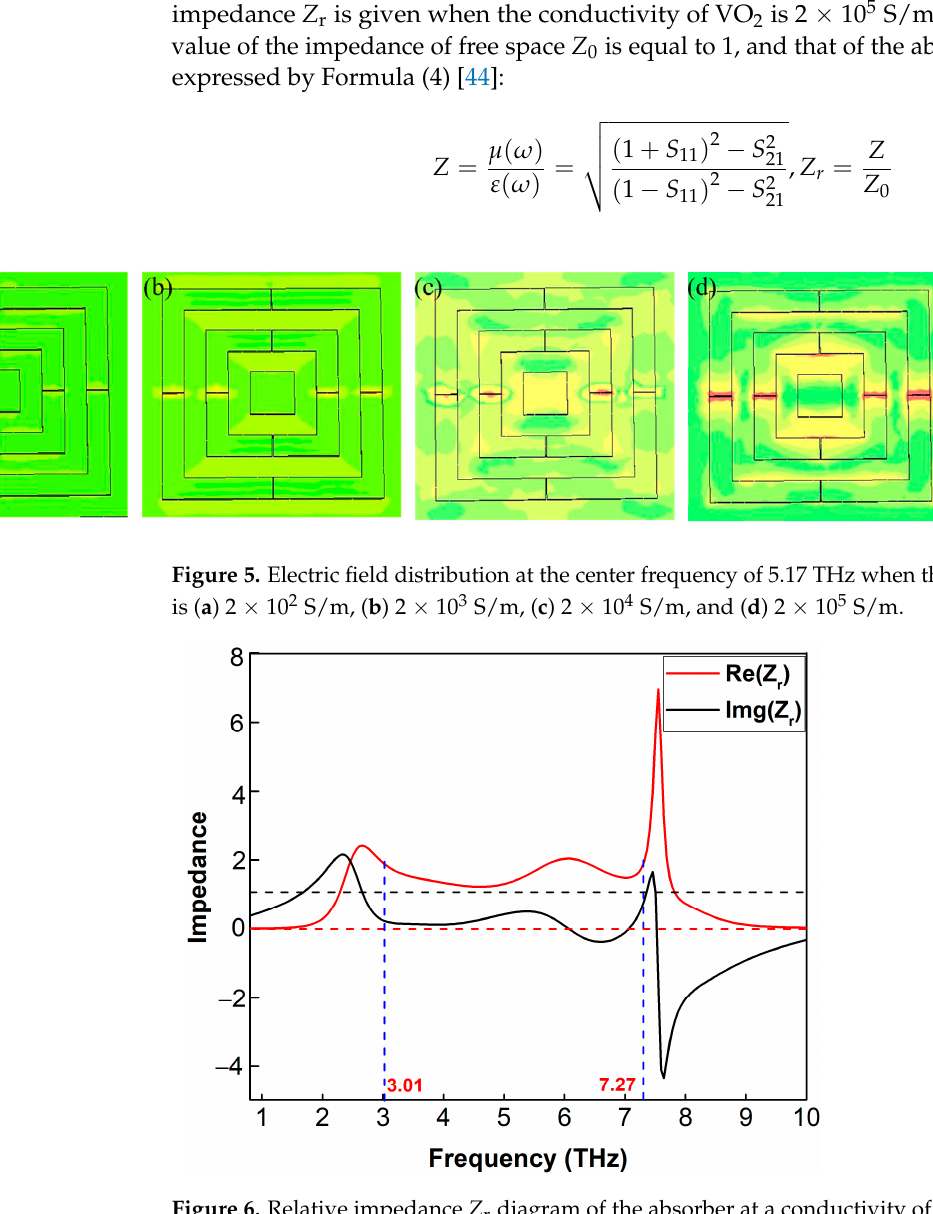
r diagram of the absorber at a conductivity of 2 × 10